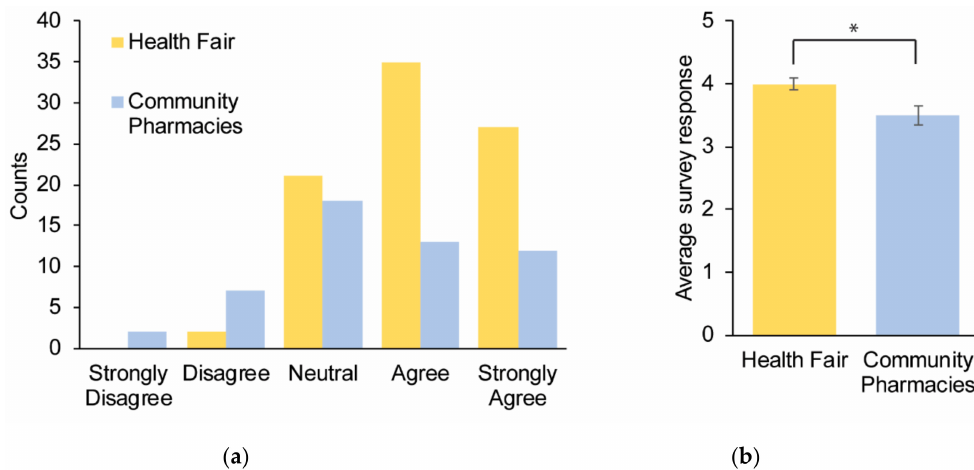
Figure 2. Survey responses to the question: “I am interested in pharmacogenomics”. A total of 137 participants provided responses across multiple sites and were subsequently categorized as the symposium ( n = 85) and community pharmacy ( n = 52) participants. ( a ) Cumulative responses for each category depicted by di ff erent colors for the two cohorts. ( b ) The average survey response for the two cohorts. Error bars = SEM.